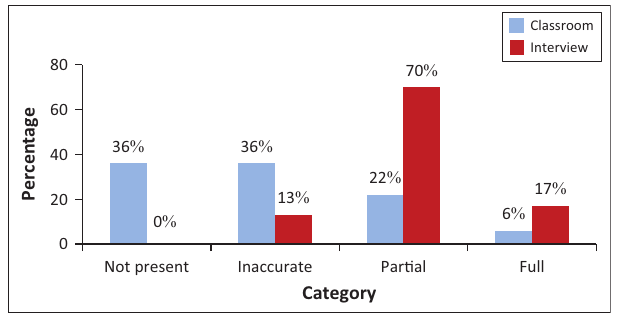
FIGURE 3: Procedural explanations in relation to the error (averages across all